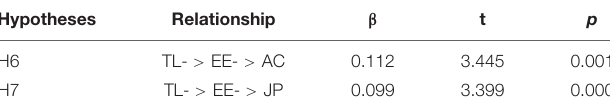
TABLE 5 | Specific indirect